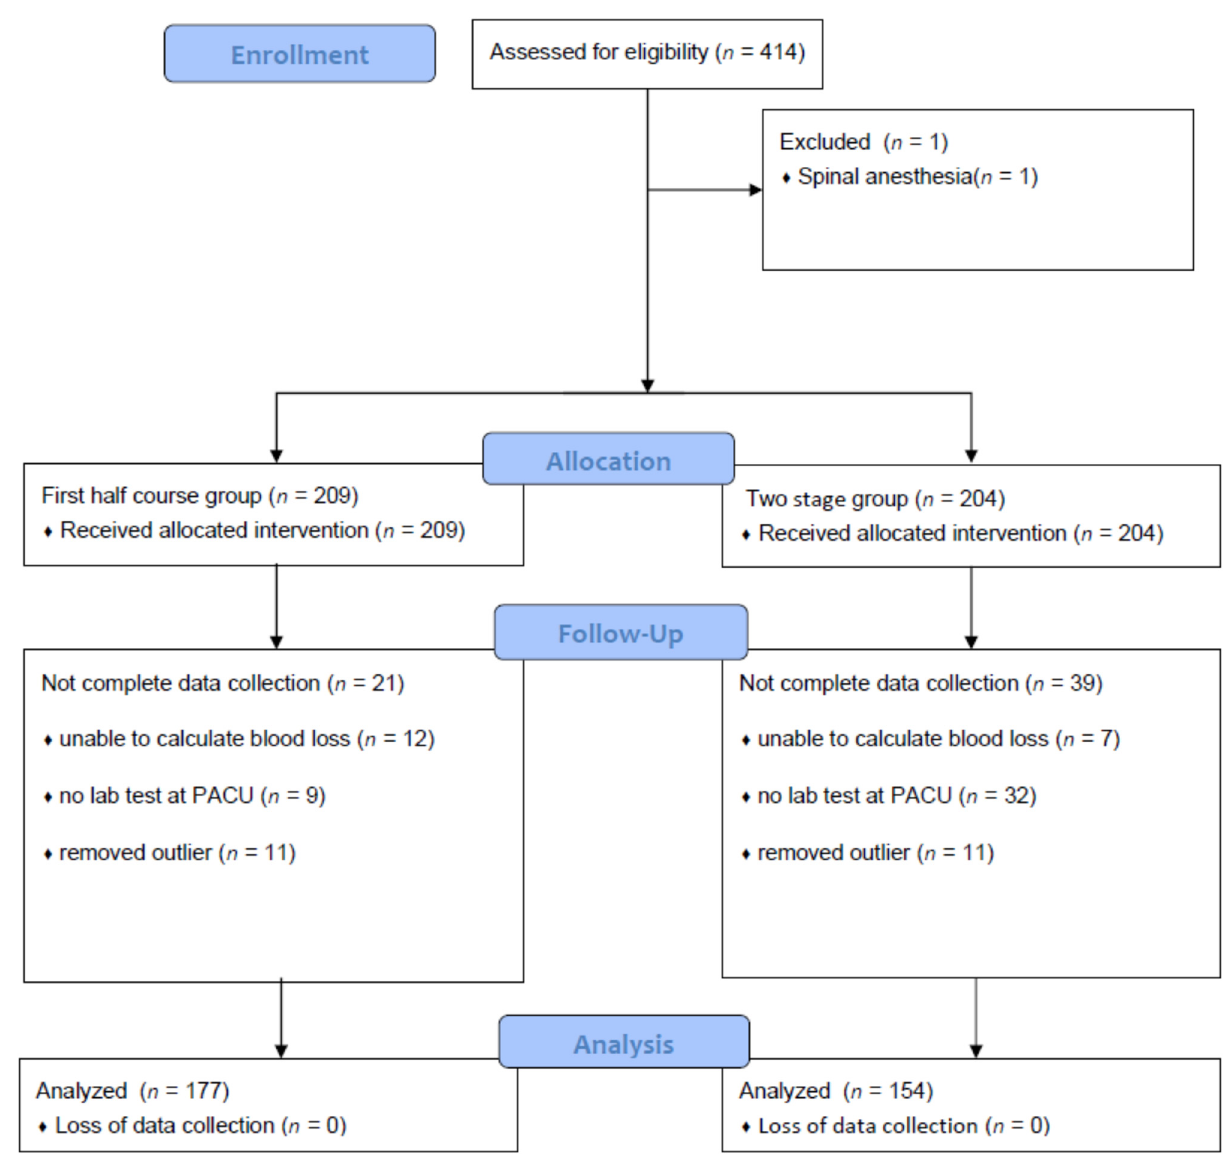
Figure 1. Flow diagram of patient selection.